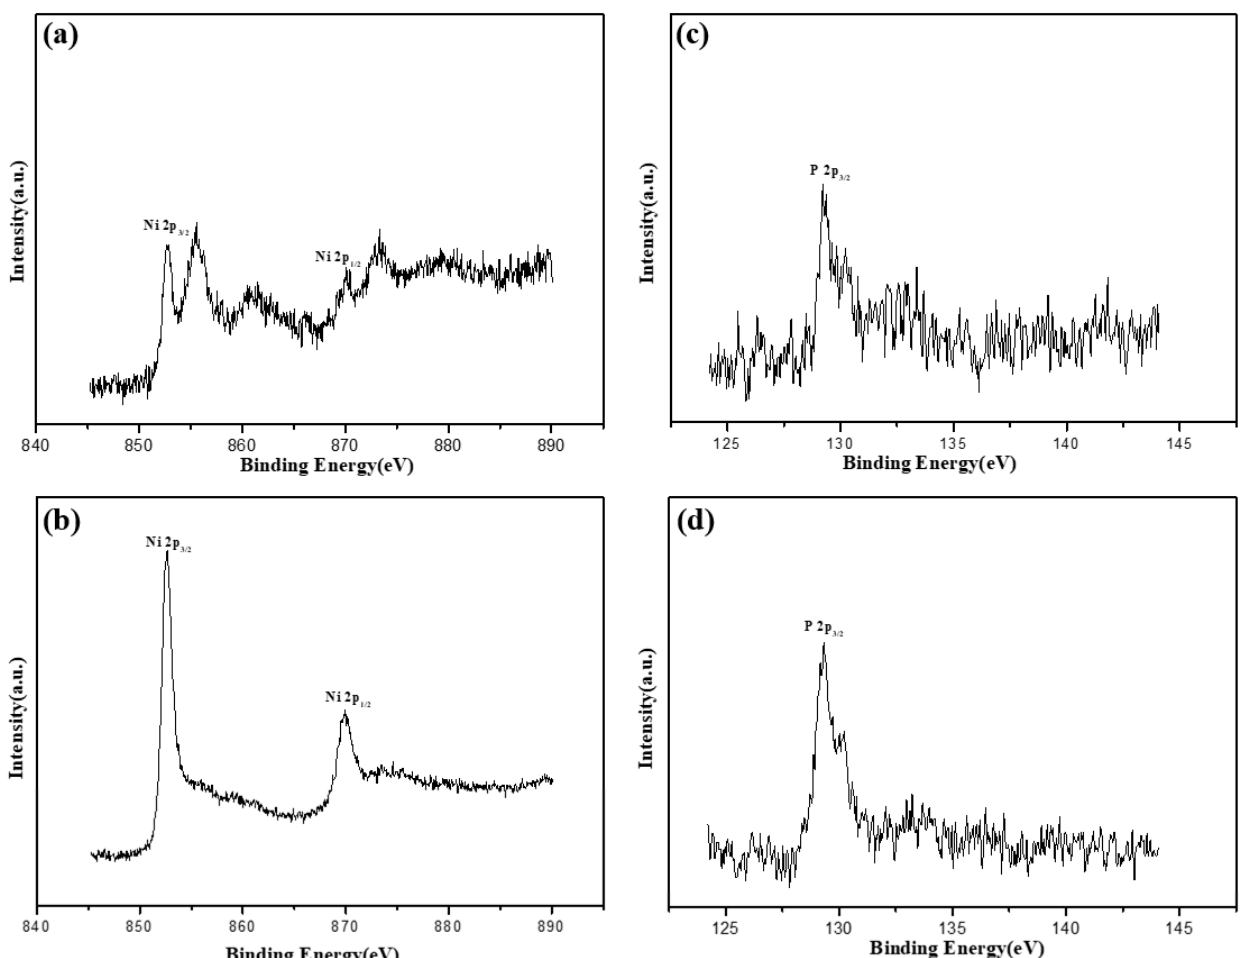
Figure 7. XPS analysis of Ni and P after corrosion of ground-state coating. ( a ) XPS spectrum of Ni, ( b ) XPS spectrum of Ni after etching for 30 s, ( c ) XPS spectrum of P, ( d ) XPS spectrum of P after etching for 30 s.